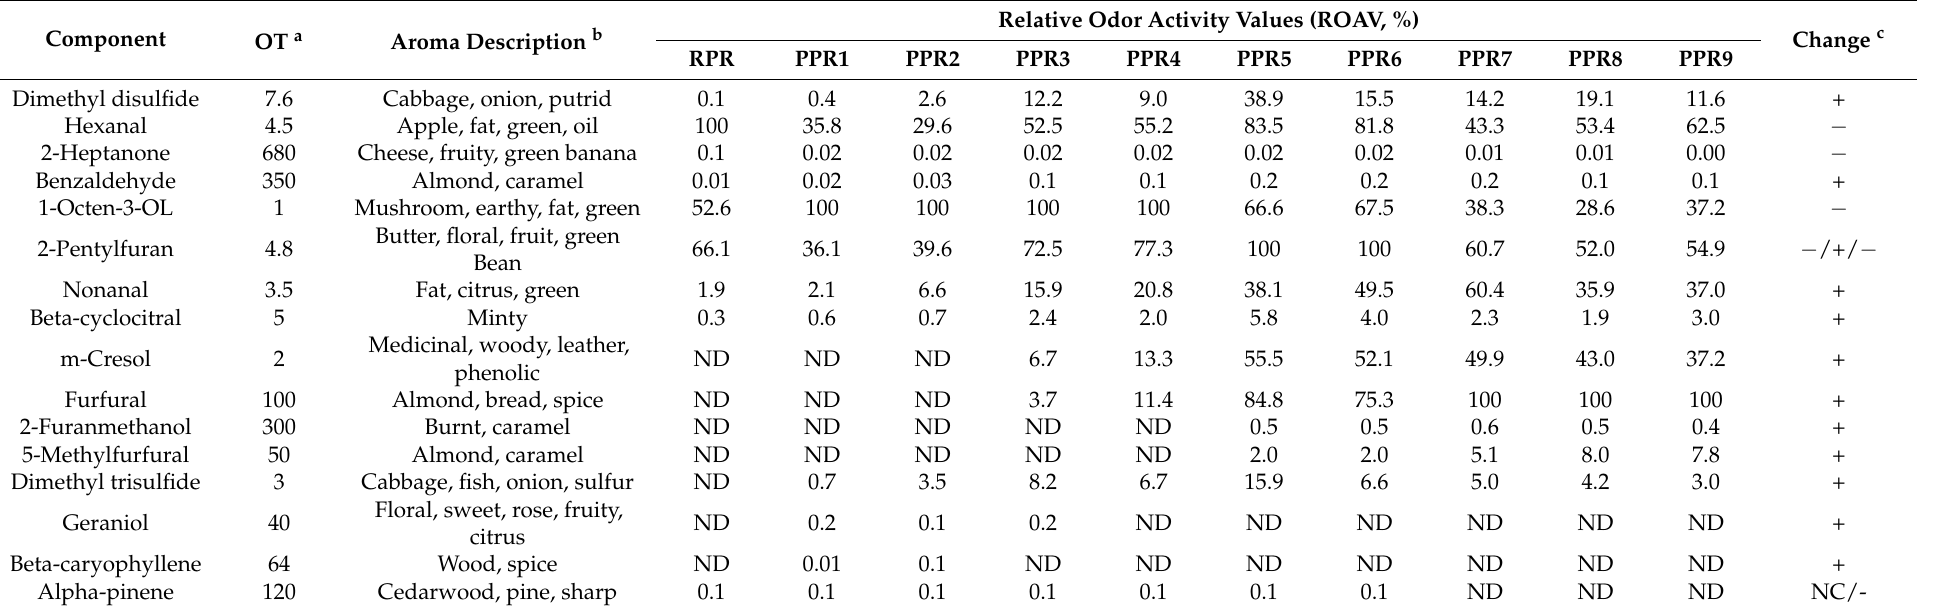
Table 3. Key flavor components in PR samples with different processing